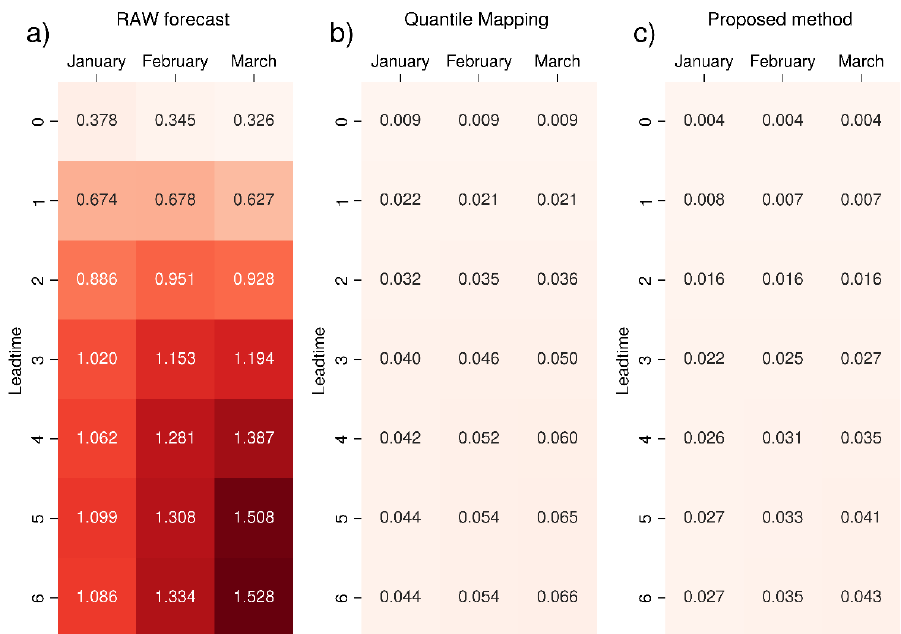
Figure 5. RMSE (m) of the total precipitation 99th percentile value for seasonal forecast SEAS5 (ECMWF) compared to ERA5 reanalysis: ( a ) raw data, ( b ) data corrected standard with quantile mapping and ( c ) data corrected with the proposed bias correction method. The colour scale ranges from white (RMSE = 0) to dark red, increasing in intensity as the metric increases. The most intense colour corresponds to the maximum value (in this case, 0.013 m for January and lead time six).